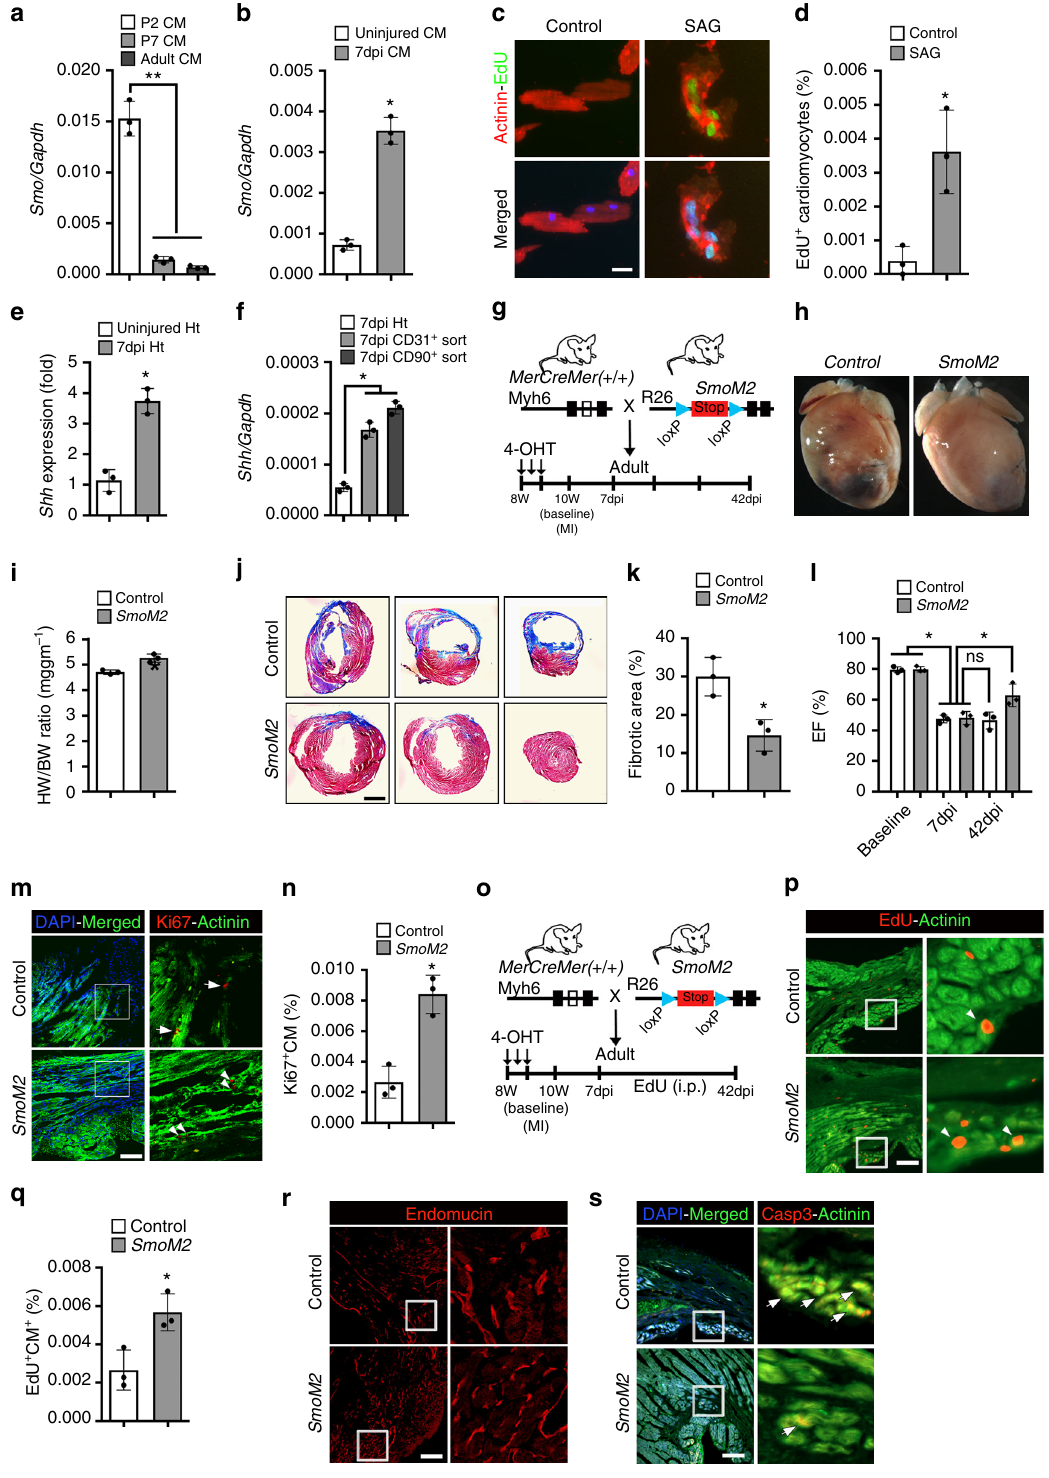
mouse neonatal cardiomyocytes (Supplementary Fig. 8c, d). To proliferation, we performed lentiviral-mediated overexpression and knockdown of Gli1 in neonatal cardiomyocytes (Fig. 8a